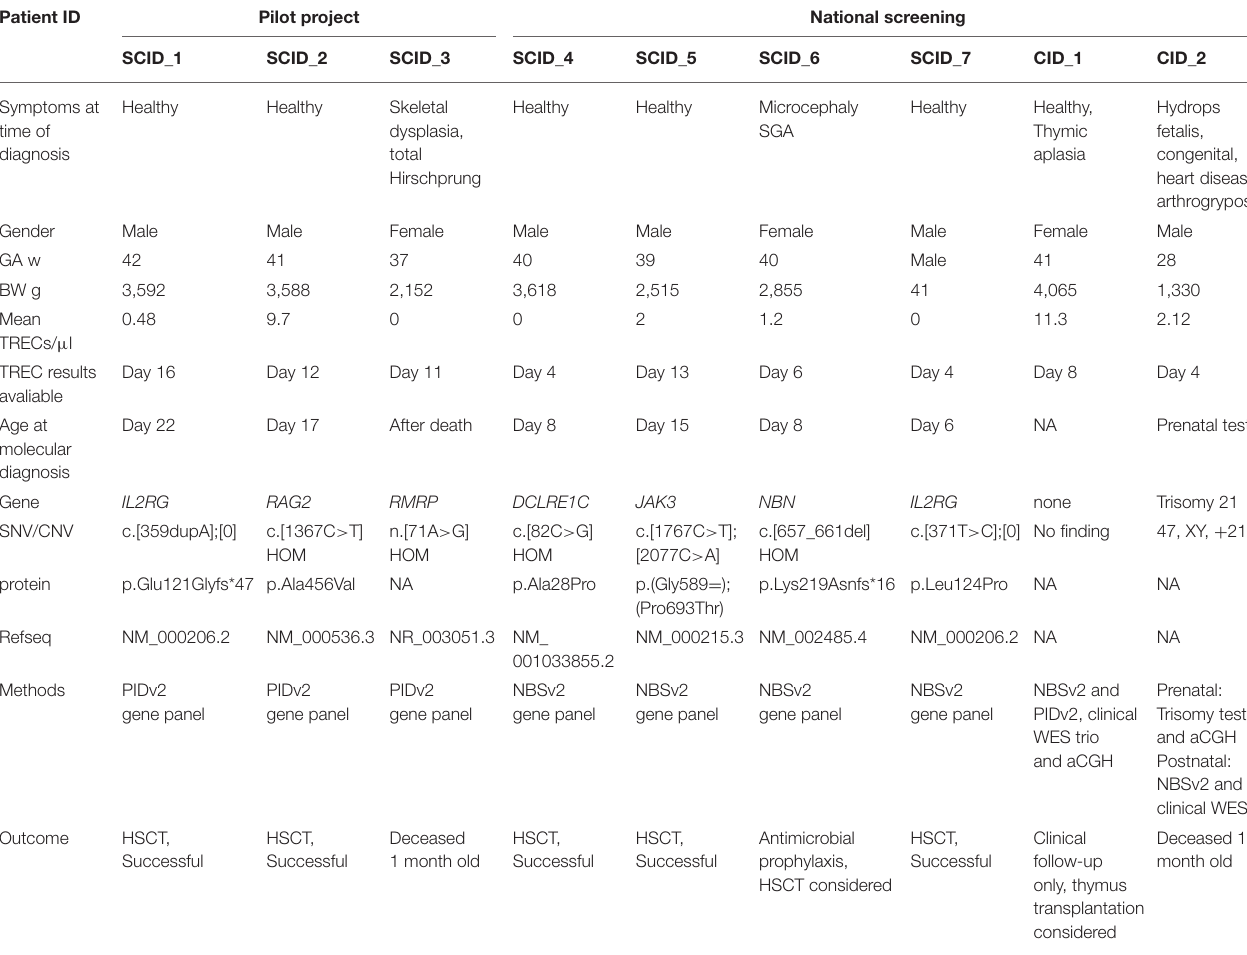
TABLE 1 | New SCIDs and severe T cell deficiencies identified on newborn screening. Patient